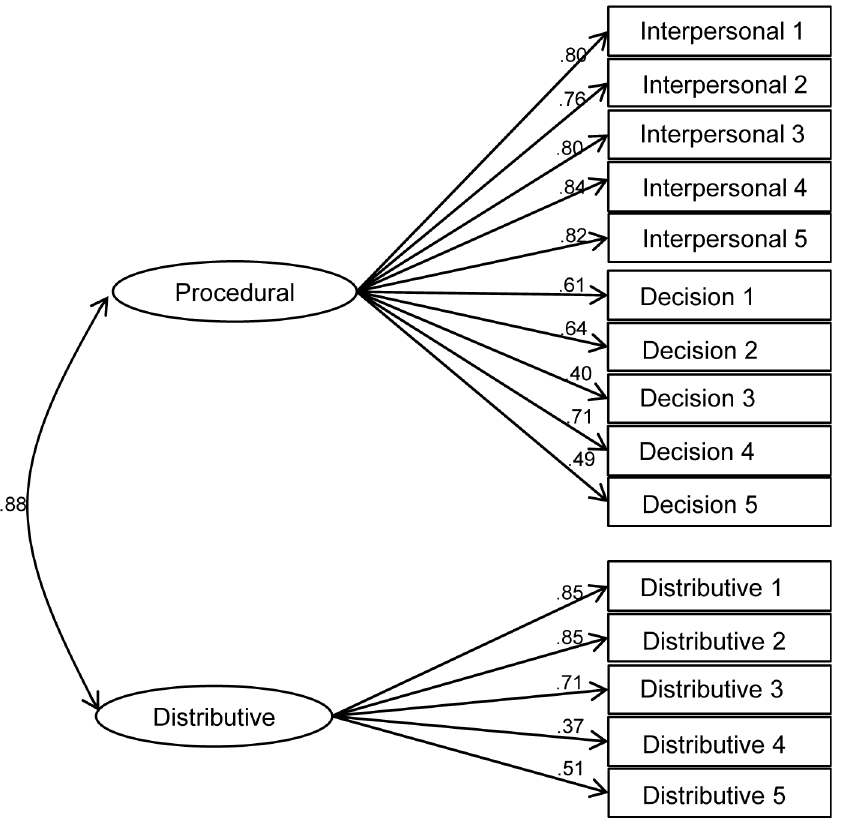
Fig 3. Standard two-factor model of police fairness (procedural and distributive fairness; model B).